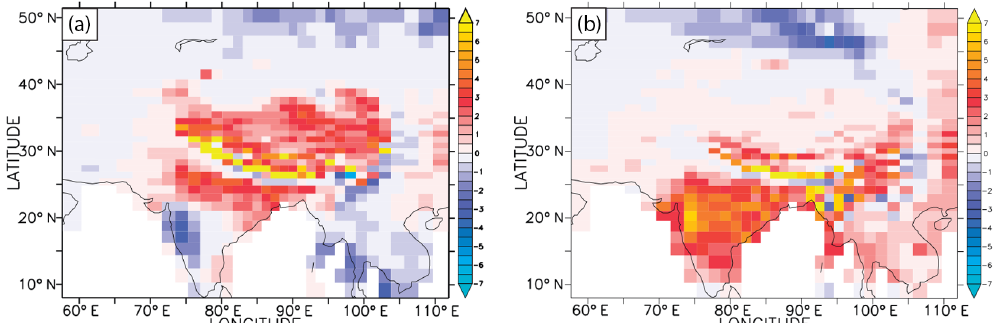
Figure 14. Precipitation change (mm day − 1 ) for (a) MOD-INT (b) INT-LOW cases.